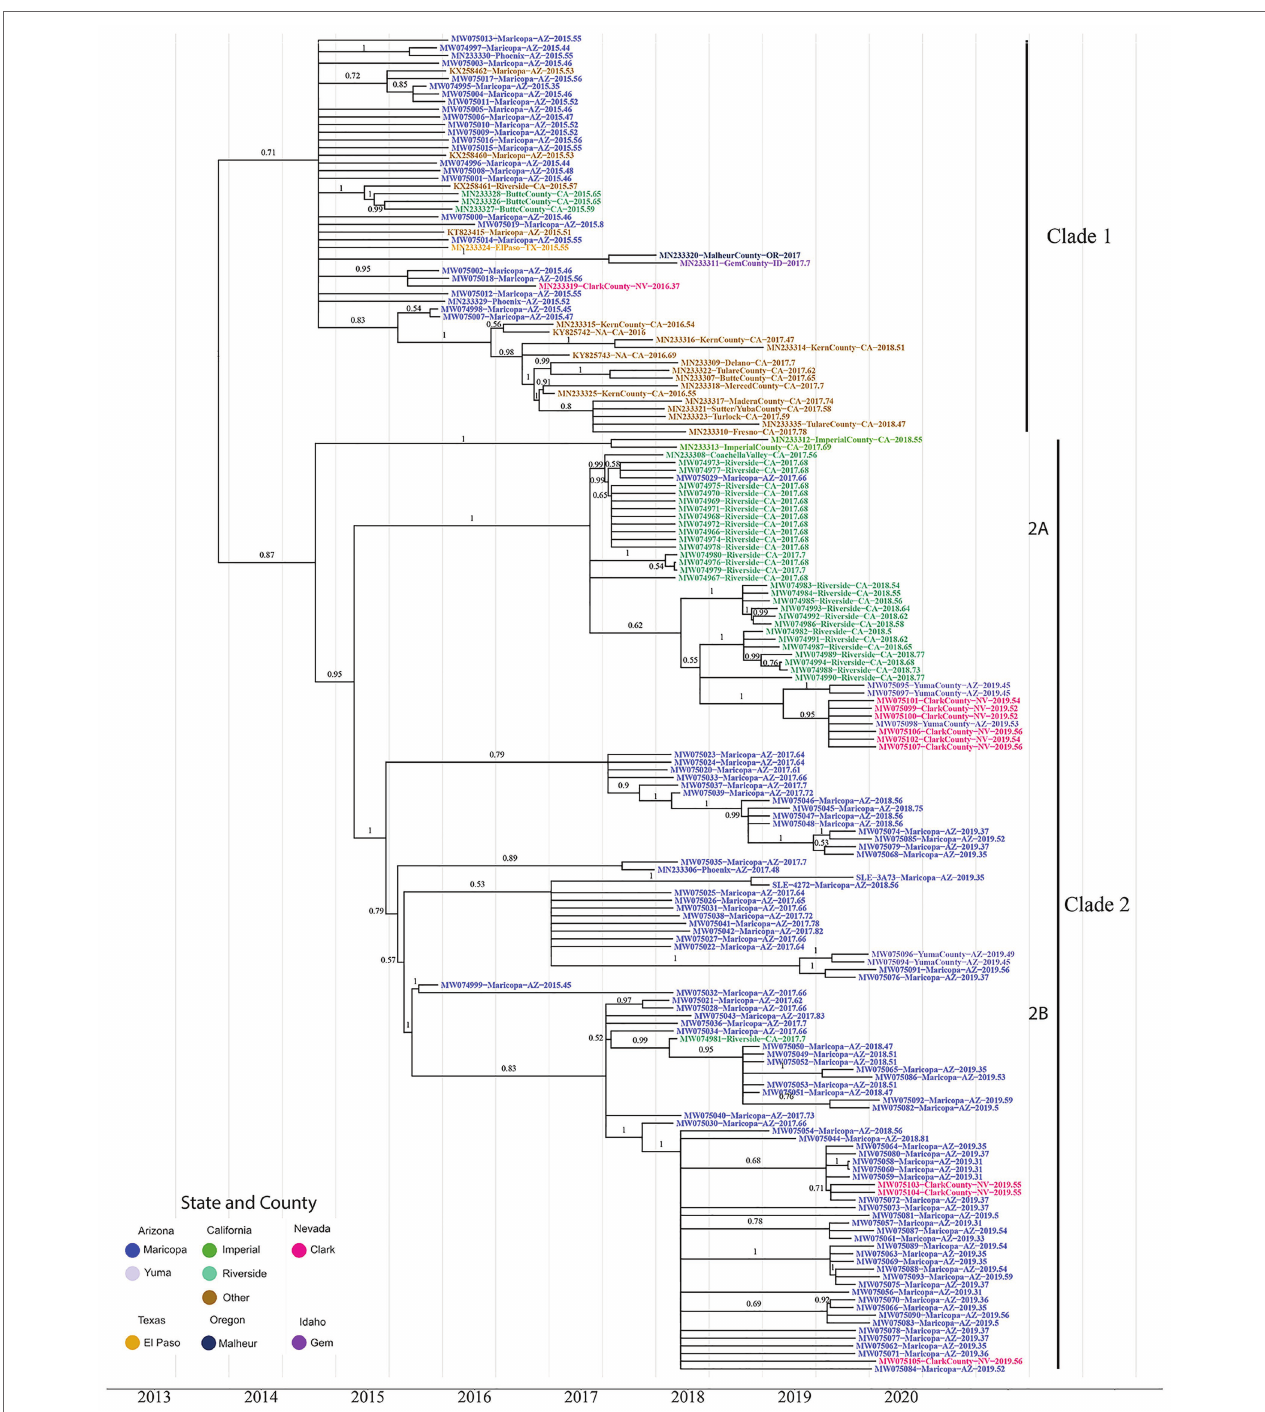
FIGURE 1 | The maximum clade credibility phylogenetic tree reconstructed using 174 genotype III St. Louis Encephalitis Virus (SLEV) genomes throughout the Southwest. The tip colors distinguish the sampling location of each sample Arizona Counties, Maricopa (Blue), and Yuma (Gray); California Counties, Imperial (Green), Riverside (Teal), and Others (Brown); Nevada, Clark (Pink); Texas, El Paso (Yellow); Oregon, Malheur (Dark Blue); and Idaho, Gem (Purple). Posterior values for branches above 0.50 are written above their corresponding branch. Branches with posterior values below 0.5 were collapsed into polytomies ( Supplementary Figure S3 contains the BEAST tree prior to collapsing and contains the 95% HPD CI for each node). After correcting for low confidence branches, the phylogeny clusters into three distinct clades. Clade 1 consists of all the 2015–2016 California and 2015 Arizona samples. Clade 2 consists of the 2017–2018 California samples and the 2017–2019 Arizona samples. Clade 2 is further divided into two subclades 2A and 2B. Subclade 2A comprises Coachella Valley, California; Yuma County, Arizona, and Clark County, Nevada; subclade 2B comprises 2017–2019 Arizona samples, with two Yuma County and three Clark County